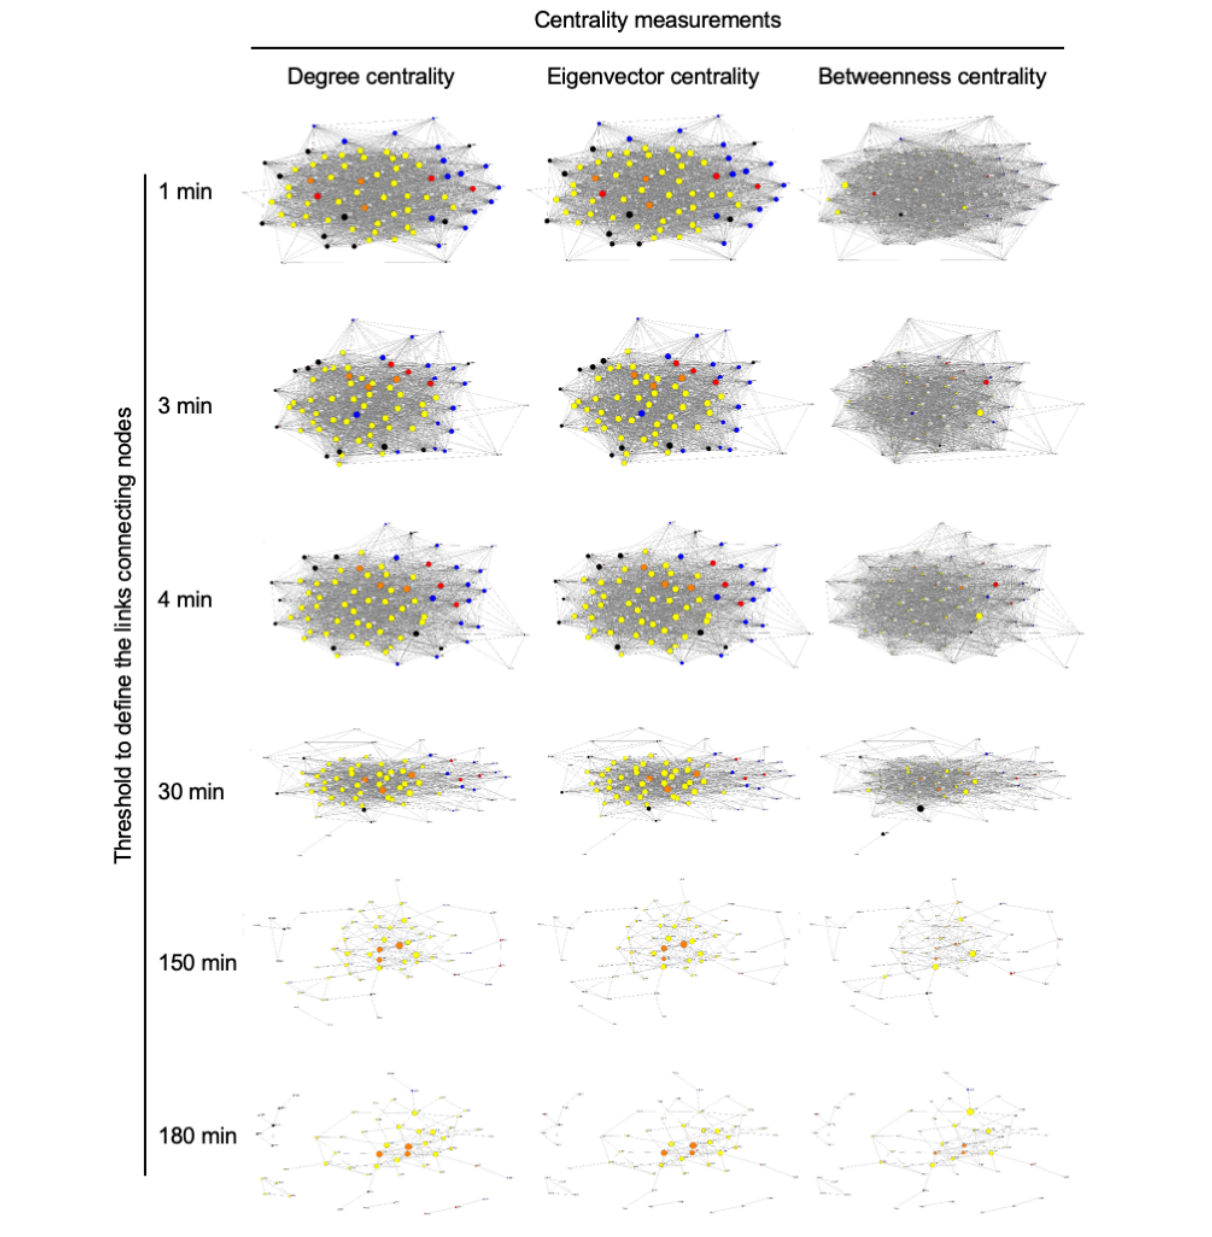
Figure 3. Centrality measurements of the social network in the active face-to-face interactions between ICU healthcare professionals. Three different centrality measures (degree of centrality, eigenvector centrality, and betweenness centrality) were used. Nodes represent individual ICU staff: blue and red, doctors; yellow and orange, nurses; black, other professions. The top 3 doctors and nurses who actively interacted the most are denoted by red and orange nodes, respectively as shown in Figure 2. Threshold values used to define those links connecting the nodes are 1, 3, 4, 30, 150, and 180